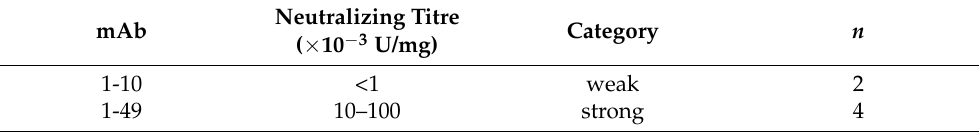
Table 2. Neutralizing capacities of anti-DTxd mAbs. Anti-DTxd mAbs were tested in a Vero cell diphtheria toxin neutralization assay to determine their neutralizing titres (endpoint assay, one unit of antibody neutralizes one Lf of toxin). Assay was repeated up to five times for each mAb (limited due to reagent availability). Results were consistent for all repeats.